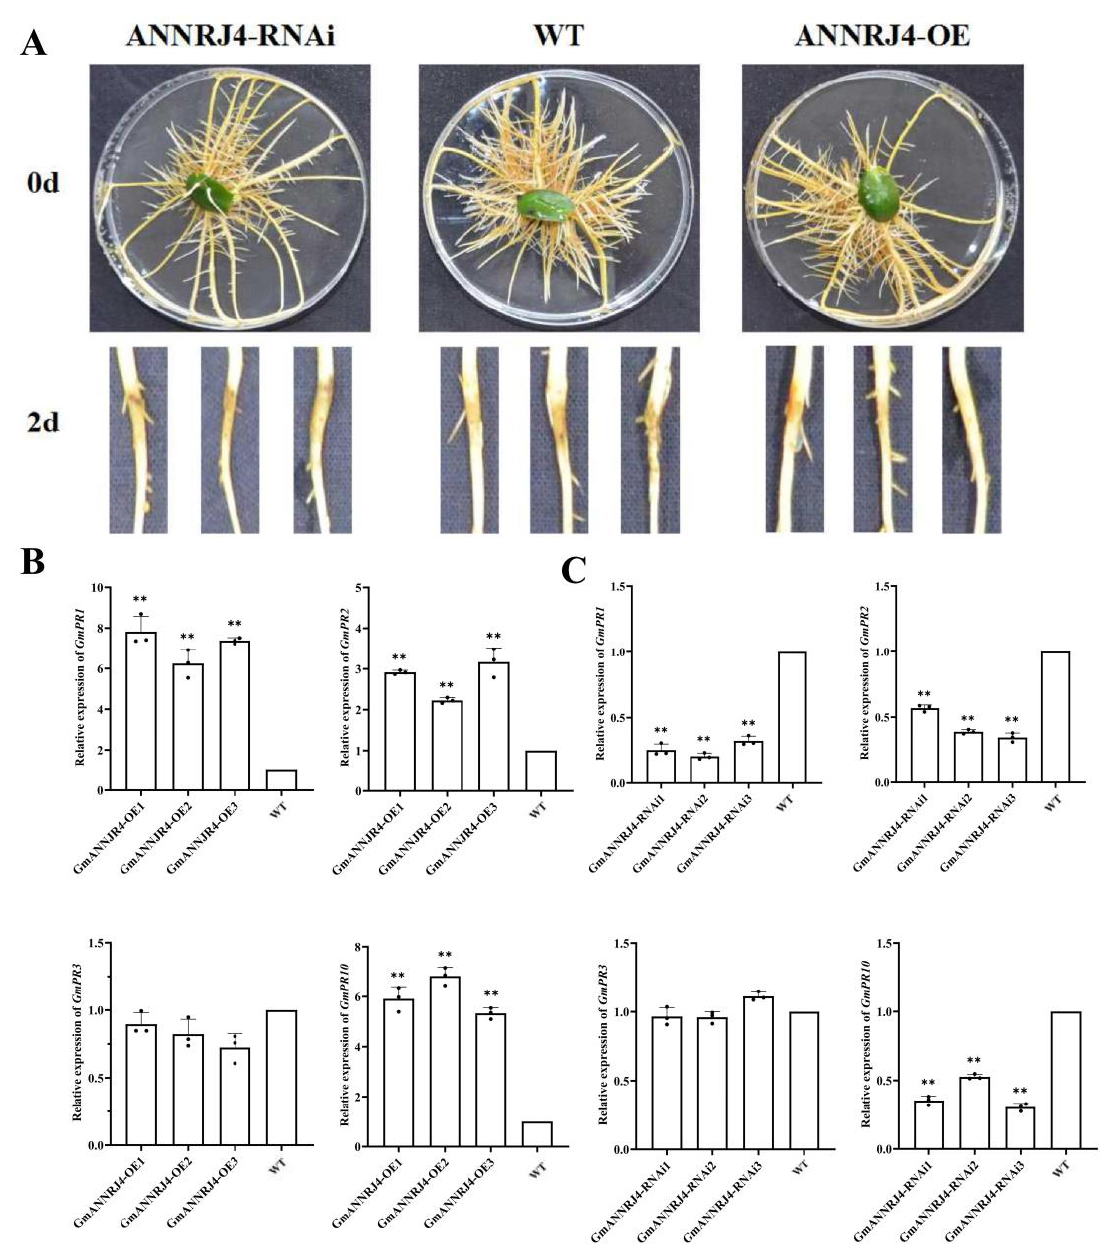
Figure 7. Response of GmANNRJ4 to P. sojae in hairy roots of transgenic soybean. ( A ) Phenotype iden- tification of GmANNRJ4 under P. sojae influence in hairy roots of transgenic soybean. ( B , C ) Relative expression of GmPR1 (Glyma.15G062400), GmPR2 (Glyma.03g132700), GmPR3 (Glyma.02G042500), and GmPR10 (Glyma.15G145700) in GmANNRJ4 -OE and GmANNRJ4 -RNAi transgenic plants. Three biological replicates, each with three technical replicates; ** p < 0.01, Student’s t test; error bars indicate standard deviation.